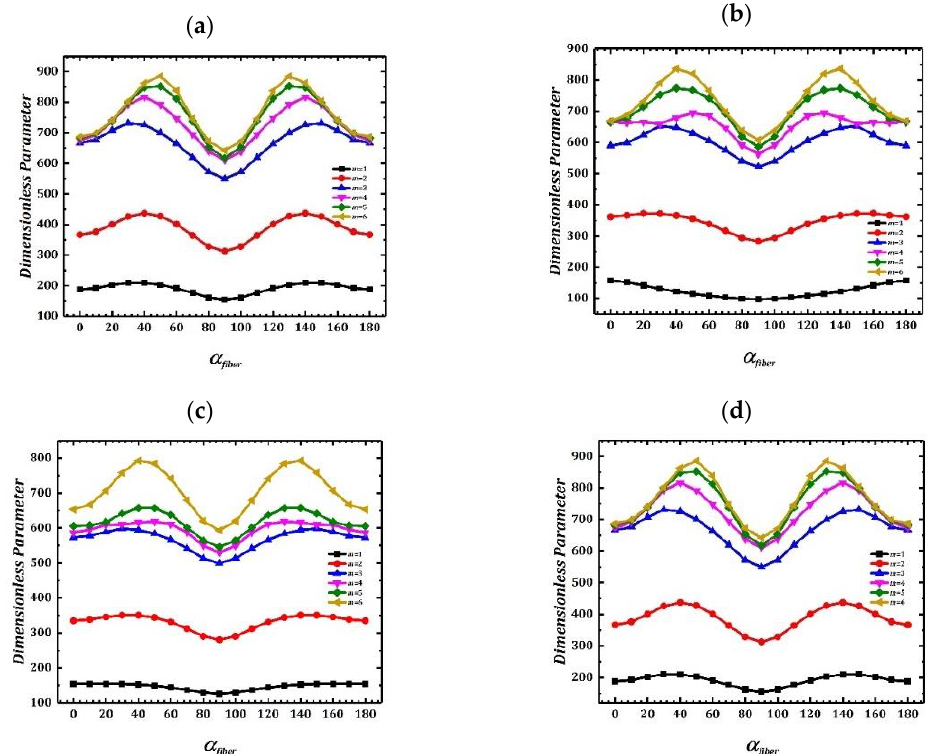
Figure 4. Variation of frequency parameter with various fiber angles of LCDCSS under classical and elastic boundary conditions. ( a ) CC-CC; ( b ) SS-SS; ( c ) E 1 E 1 -E 1 E 1 ; ( d ) E 2 E 2 -E 2 E 2 .